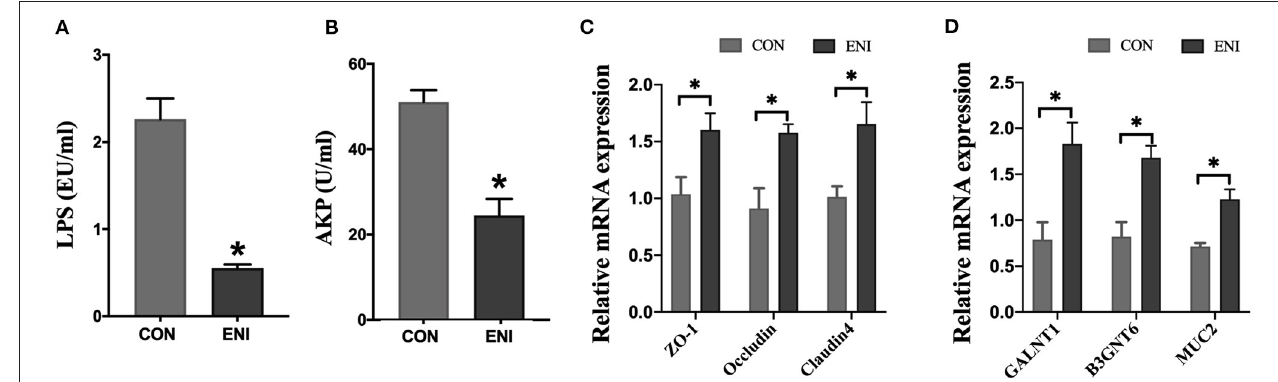
FIGURE 2 | Effects of early-life nutrition interventions on the intestinal barrier of the colon in piglets. CON, control group, ENI, early-life nutrition interventions group. (A) The content of LPS in plasma. (B) The activity of AKP in serum. (C) The mRNA expression levels of ZO-1, Occludin, and Claudin4 in the colon. (D) The mRNA expression levels of GALNT1, B3GNT6, and MUC2 in the colon. Data are expressed as mean ± SEM ( n = 4). The independent-samples t -test was used to compare data between two groups. * P <